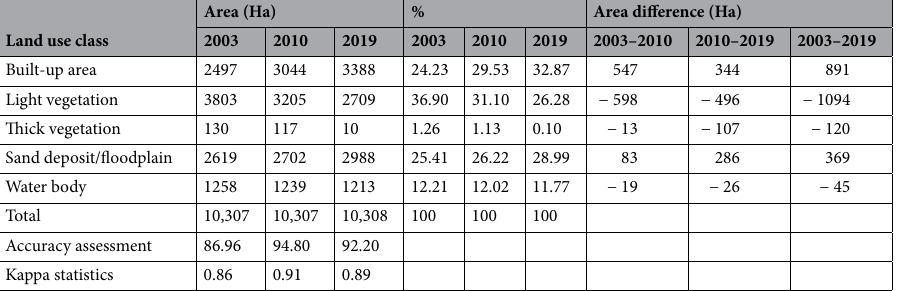
Table 3. Land use/land cover change in the watershed from 2003 to